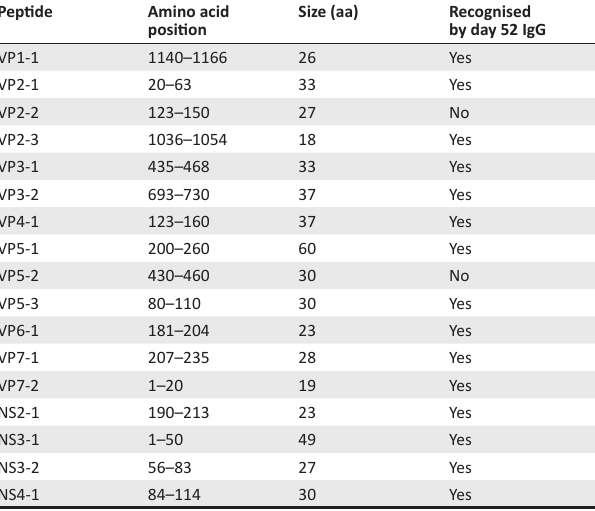
TABLE 1: Potential antigenic regions on African horse sickness virus-4 proteins. Peptide Amino acid Size (aa) position